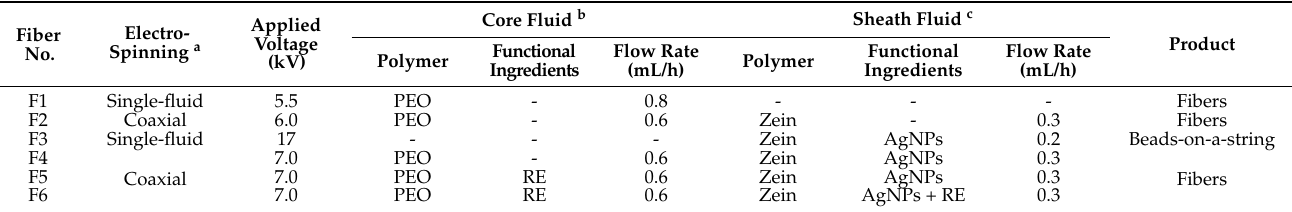
Table 1. Electrospinning processing parameters for prepared